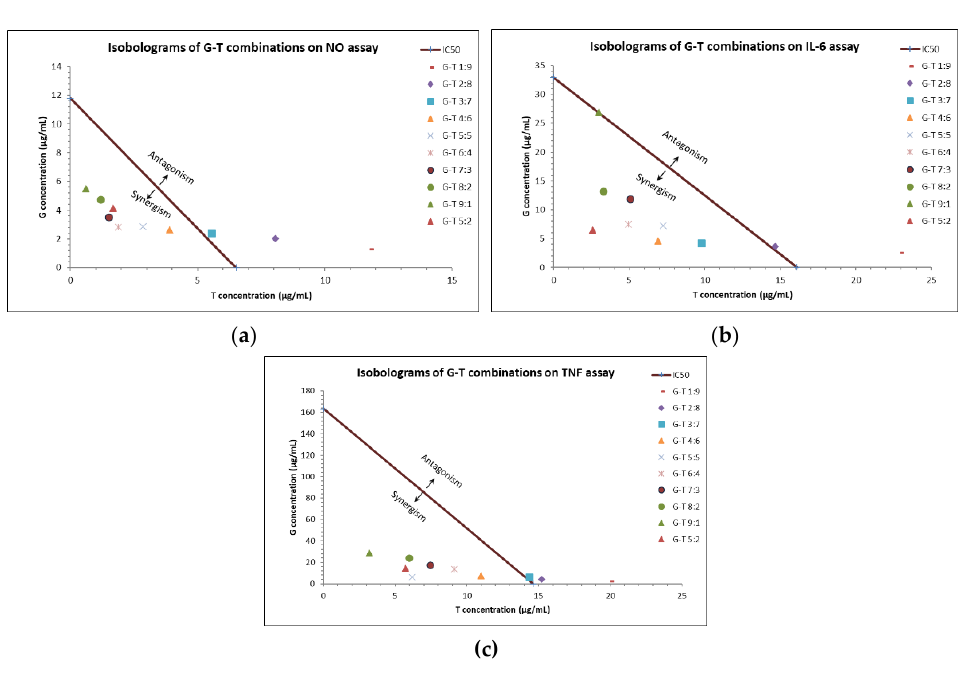
Figure 1. Interactions of G-T combinations (1:9, 2:8, 3:7, 4:6, 5:5, 6:4, 7:3, 8:2, 9:1, 5:2, w/w ) in reducing LPS-induced NO, IL-6 and TNF in RAW 264.7 cells as analysed by isobologram. Isobologram of G-T combinations at IC 50 on NO ( a ), IL-6 ( b ) and TNF ( c ) assays.